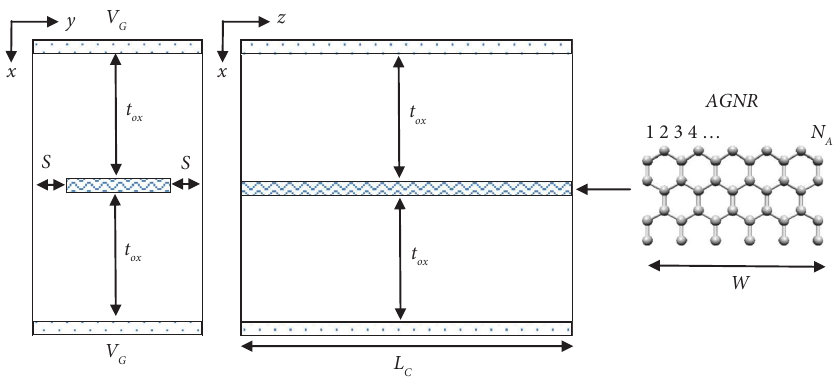
Figure 1: Schematic structure of the SB-GNR-FET used in the simulation